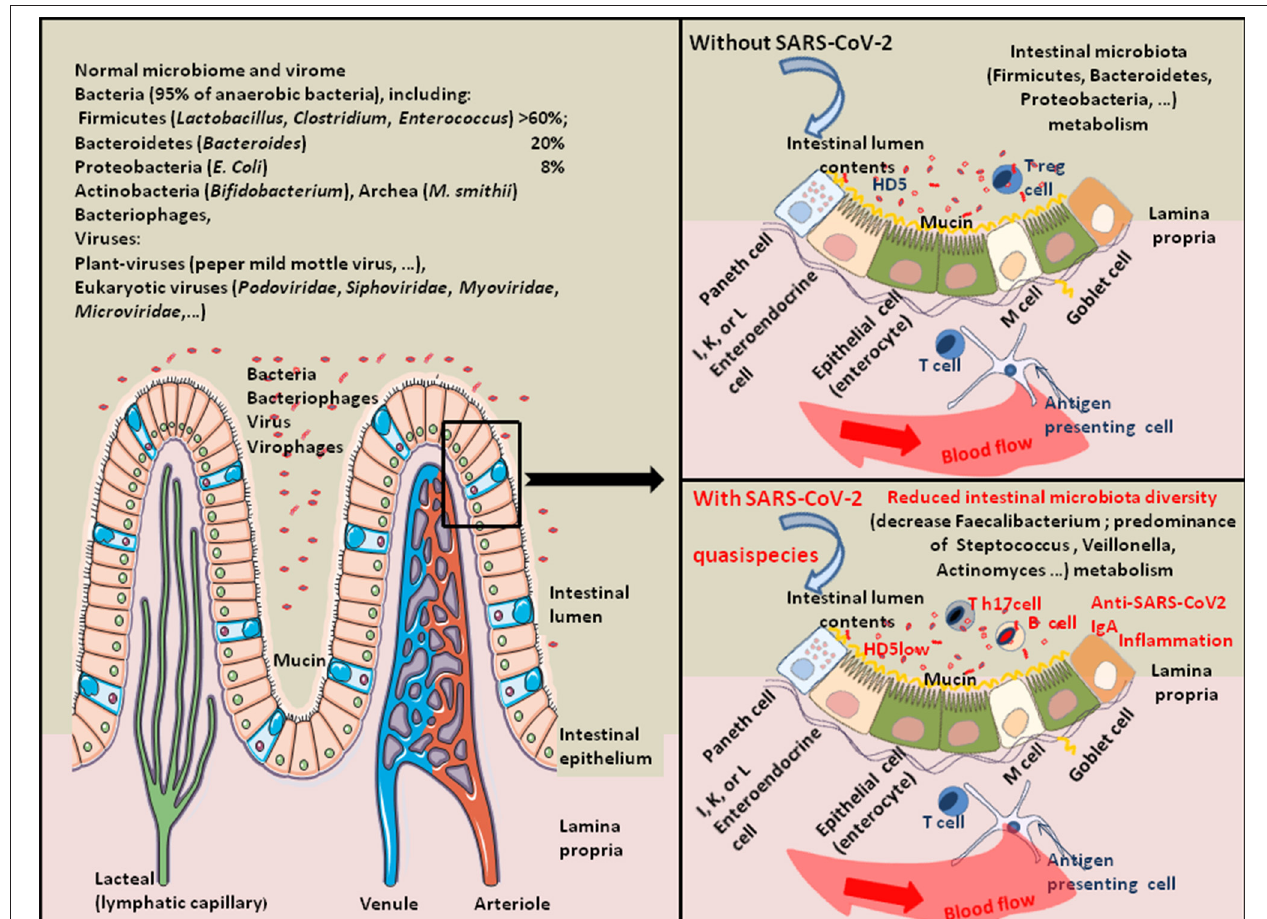
FIGURE 3 | Schematic representation of SARS-CoV-2-associated intestinal dysbiosis. Once in the GIT, SARS-CoV-2 acts on the gut microbiota homeostasis and sometimes induces severe dysbiosis. About 100 trillion bacteria present in the intestinal lumen compose the human gut microbiota. It is a quite complex ecosystem, with over 1,000 bacterial species and 7,000 strains, in which the phyla Firmicutes (species, such as Lactobacillus , Enterococcus , and Clostridium ) and Bacteroidetes (species, such as Bacteroides ) account for the majority of species. Other phyla including Proteobacteria ( Escherichia coli ), Actinobacteria (Bifidobacteria), Cyanobacteria, Fusobacteria, and Verrucomicrobia are also present in lower abundance ( 149). The commensal intestinal microbiota is limited to the epithelium-distal mucus layer, while the epithelium-proximal mucus is largely devoid of bacteria. Viruses are also present in the human gut. They include bacteriophages, Myoviridae , Siphoviridae , Podoviridae , Tectiviridae , Inoviridae , Microviridae , among others (150). The gut microbiota expresses enzymes allowing the production of essential vitamins (such as vitamin K, B1, B6, B9, and B12). Bacteria from the Firmicutes, Bacteroidetes, and Actinobacteria phyla are involved in bile acids metabolism, liberating free primary bile acids, up-regulating the mucosal defenses and controlling the cholesterol homeostasis. Butyrogenic bacteria (such as Firmicutes), are ubiquitously present in the gut microbiota of healthy humans. These bacteria are very sensitive to oxidative stress. They produce butyrate, an end-product of anaerobic bacteria fermentation of non-digestible carbohydrates is considered a crucial protective molecule against inflammation. The butyrate inhibits the histone deacetylase HDAC, increases the junctional adhesion molecules JAM/occludin involved in the stability of tight junctions, and antagonizes the peroxisome proliferator-activated receptors (PPARs) that control inflammation [see the review (151) for details]. Many viruses (e.g., rotaviruses, caliciviruses, astroviruses, enteric adenoviruses, toroviruses, and parechoviruses) are known to induce gastroenteritis in humans (40). Coronaviruses are also frequently associated with diarrheal disease in humans. Regarding SARS-CoV-2, studies of gut microbiota have indicated a decrease in bacteria diversity in severe COVID-19 patients characterized by a decrease in Faecalibacterium ( Faecalibacterium prausnitzii ) and predominance of Streptococcus , Veillonella , Actinomyces , Clostridium , Bacteroides . The expression of antimicrobial compound HD5 and Vitamin D3 were also found reduced in COVID-19 patients.